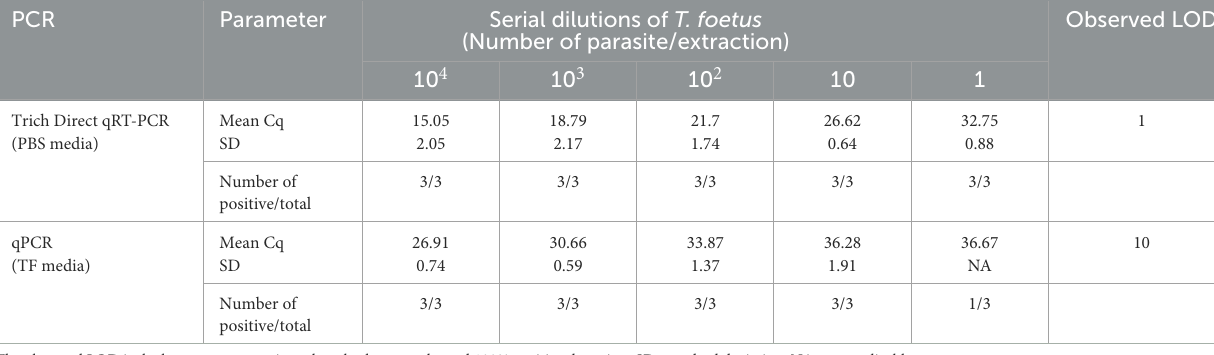
TABLE 2 Limit of detection comparison between Trich direct RT-qPCR and qPCR across three replications. PCR